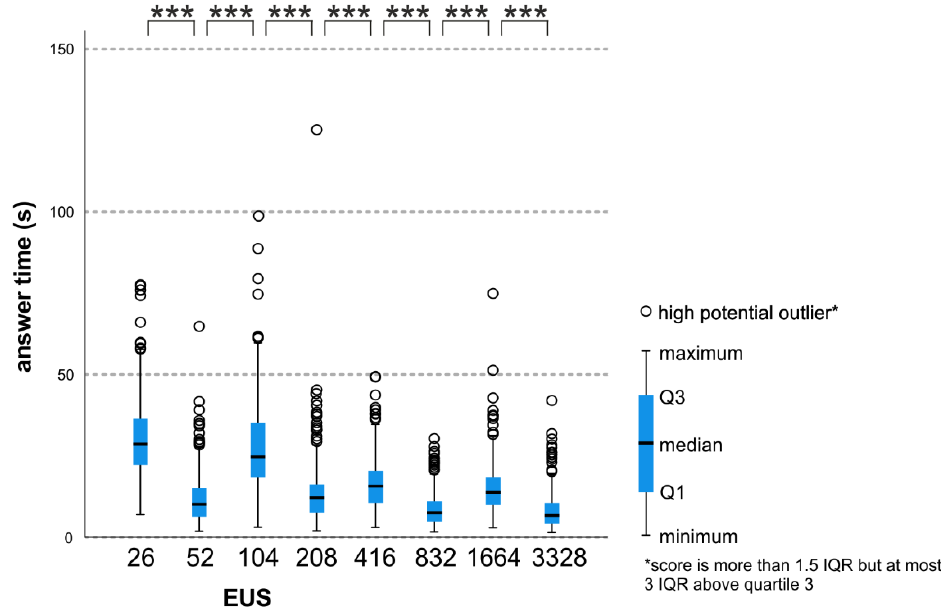
Table 5. The pairwise comparison of the answer times for task 3, *** p ≤ 0.001. Kruskal-